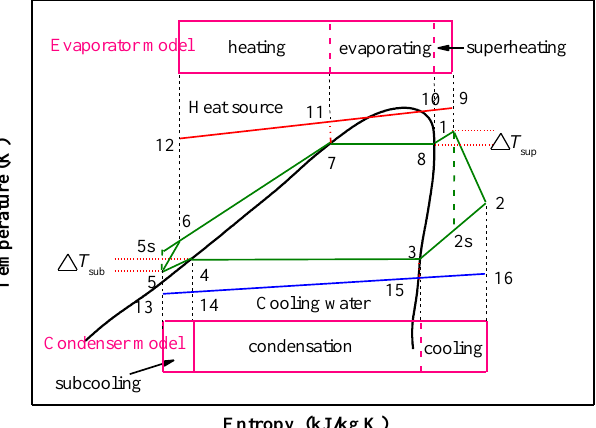
Figure 3. T-s plot of the organic Rankine cycle system.